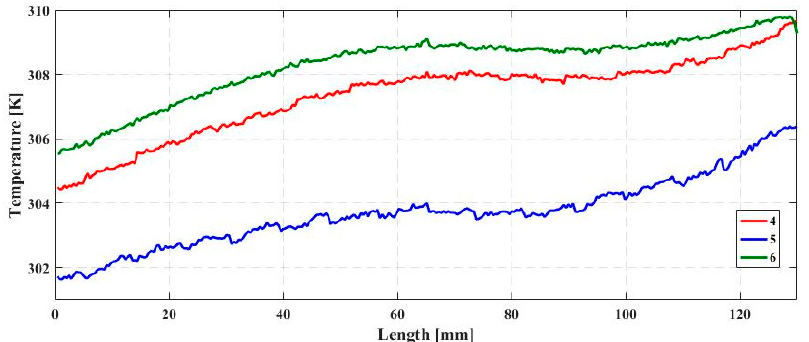
Figure 6. Temperature distributions along the selected lines (see Figure 4).